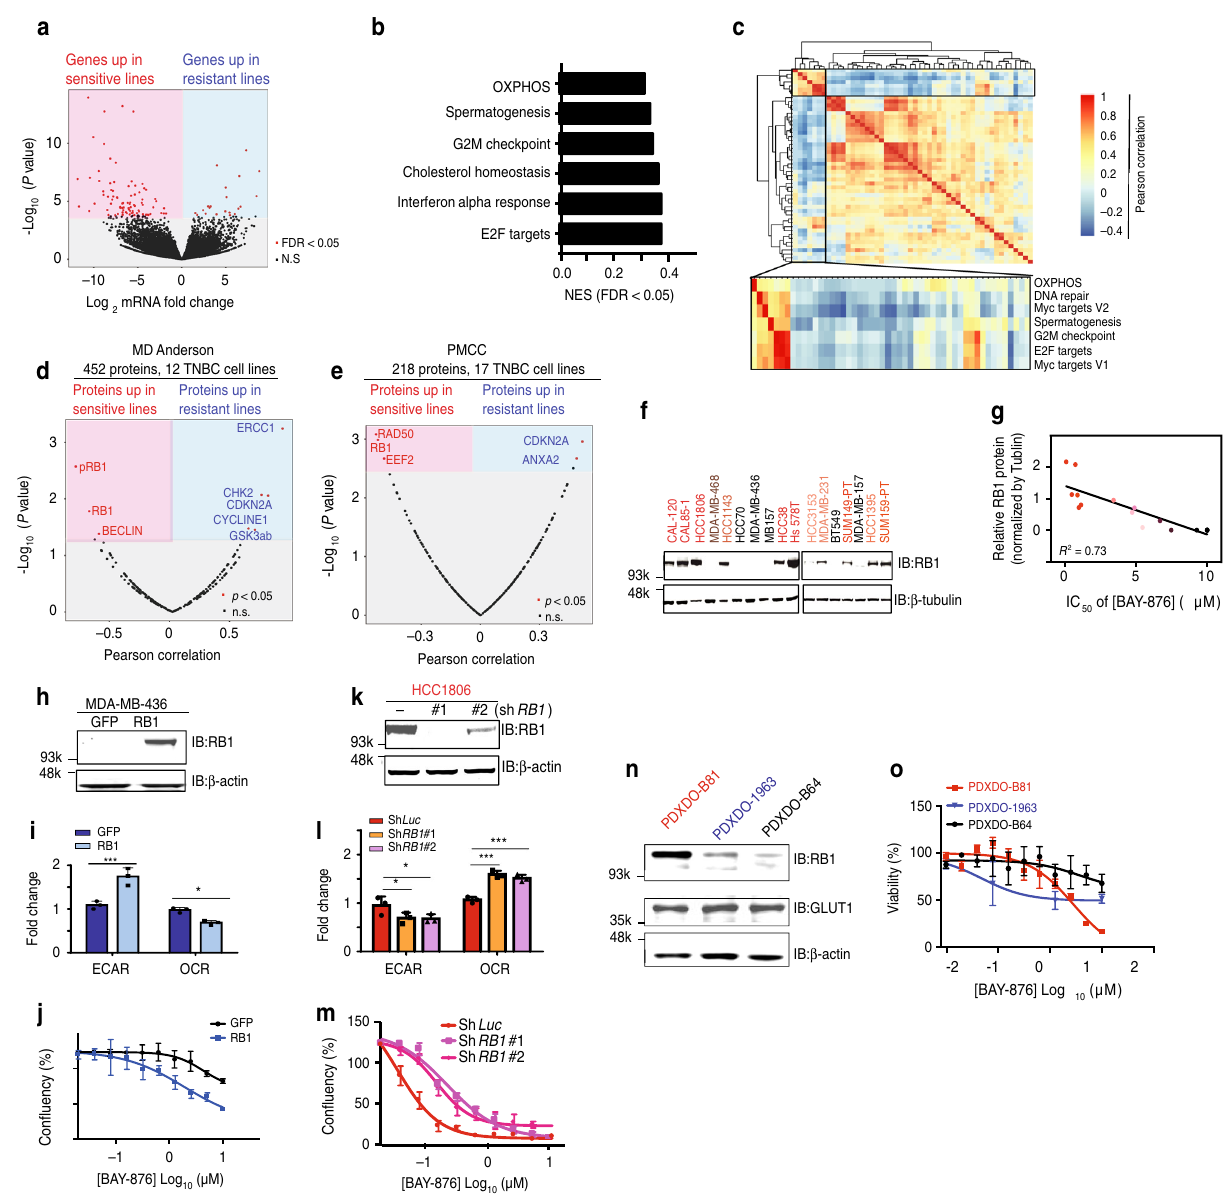
Fig. 3 RB1 protein level discriminates response to GLUT1 inhibition. a Volcano plot of log 2 fold change for all genes signi fi cantly upregulated (red; left) in sensitive lines or in resistant lines (blue; right). b Top enriched pathways in BAY-876-resistant lines compared to BAY-876-sensitive lines based on GSEA. c Heatmap of pathways correlated with OXPHOS revealed by GSEA of TCGA RNA-sequencing data. Clusters signi fi cantly related to OXPHOS are zoomed at the bottom. Pearson ’ s correlation coef fi cients between Log 2 normalized protein expression data and response of BAY-876 showing signi fi cantly associated proteins with sensitive lines (red; left) or resistant lines (blue; right) based on the dataset from d MD-Anderson Cancer Center and e Princess Margaret Cancer Center (PMCC). f Representative western blot showing the variable RB1 expression levels in 17 TNBC lines. β -tubulin as a loading control. g Correlation of RB1 protein levels and the IC 50 of BAY-876. h Representative immunoblot showing MDA-MB-436 cells expressing RB1 or GFP control proteins. β -tubulin as a loading control. i ECAR and OCR values were measured for MDA-MB-436 cells expressing RB1 or GFP control. n = 4; mean ± s.d. Two-sided Student ’ s t test. * p < 0.05; *** p < 0.001. j Growth curves of MDA-MB-436 cells expressing RB1 or GFP control in the presence of indicated concentrations BAY-876 treatment for 5 days. n = 4; mean ± s.d. k Representative western blot showing HCC1806 cells transfected with sh RB1 and sh LUC . β -actin as a loading control. l ECAR and OCR values were measured for HCC1806 cells transfected with sh RB1 and sh LUC . n = 4; mean ± s.d. Two-way ANOVA. * p < 0.05; *** p < 0.001. m Growth curves of HCC1806 cells with control knockdown or RB1 knockdown in the presence of indicated concentrations BAY-876 treatment for 5 days. n = 4; mean ± s.d. n Western blot showing the variable RB1 expression levels in a panel of three TNBC patient-derived organoids. β -actin as loading control. o Cell viability assays of patient-derived organoids with indicated concentrations of BAY-876. n = 3; mean ± s.d. Source data are provided as a Source Data fi